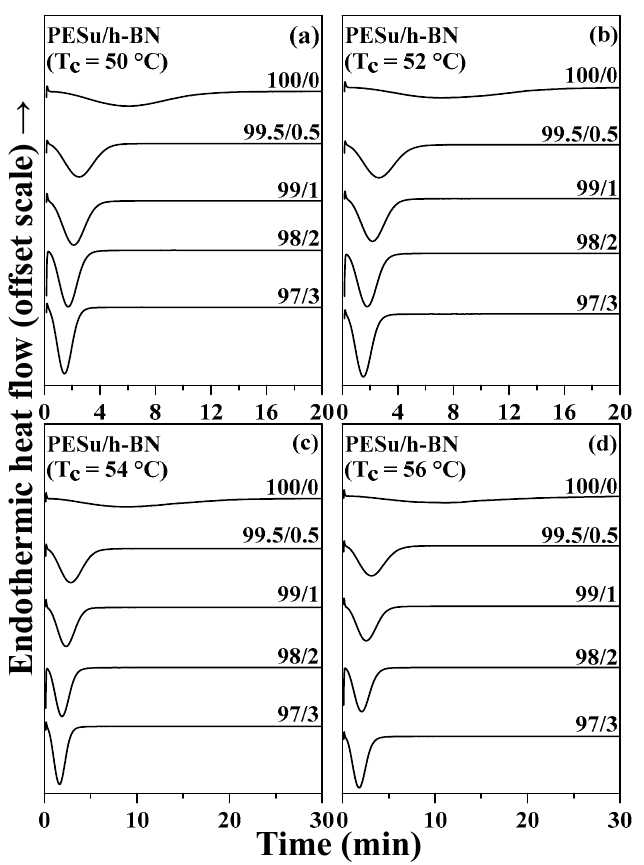
Figure 3. Isothermal crystallization thermograms of PESu/h ‐ BN composites at: ( a ) T c = 50 °C; ( b ) T c = 52 °C; ( c ) T c = 54 °C; and ( d ) T c = 56 °C. Table 1. The Avrami kinetic parameters for the isothermal crystallization behaviors of PESu/h ‐ BN composites.